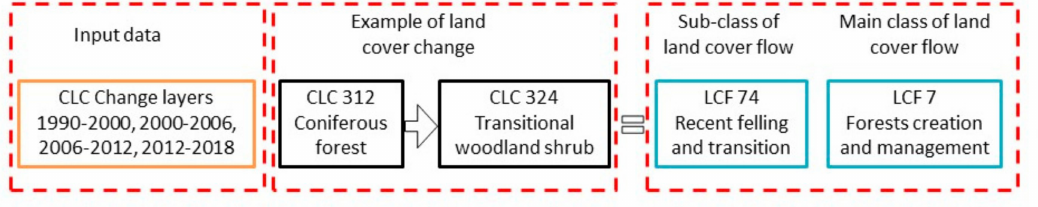
Figure 3. Methodology of the land cover